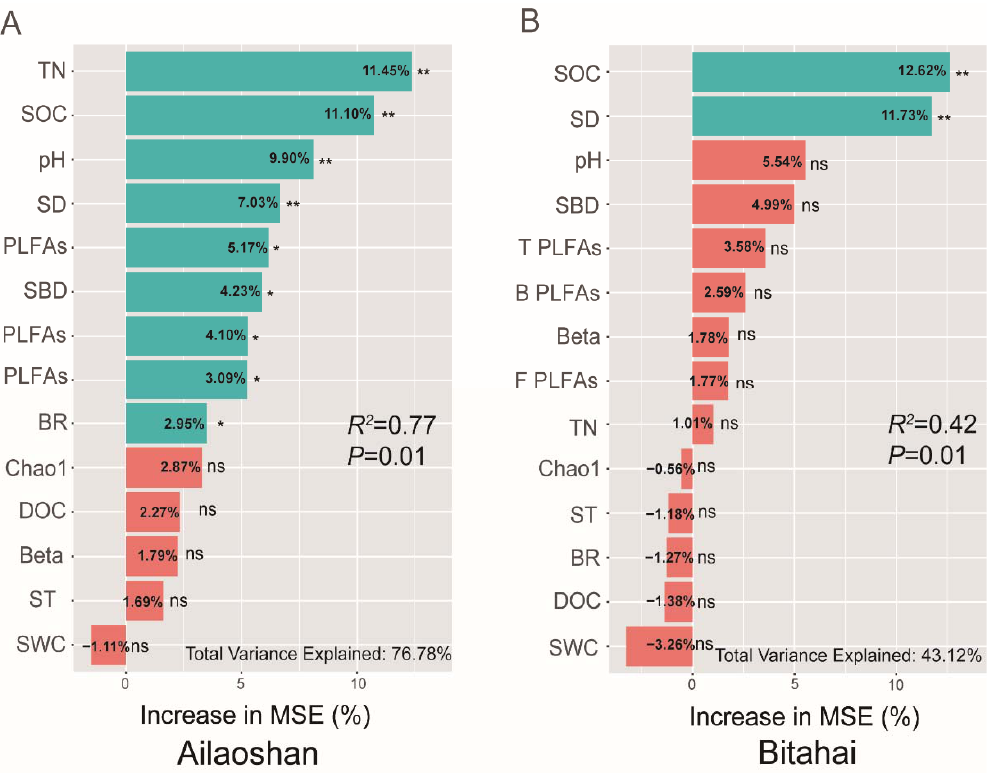
Figure 5. Effects of various factors on soil organic carbon stocks in Ailaoshan ( A ) and Bitahai ( B ) with random forest model. Factors in blue (*: P <0.05, **: P <0.01) represent sig ‐ nificant contribution to soil organic carbon stocks, while factors in red (ns) represent in ‐ significant contribution. BR: bryophyte removal, SOC: soil organic carbon, DOC: soil dis ‐ solved organic carbon, TN: soil total nitrogen, SWC: soil water content, SBD: soil bulk density, ST: surface temperature, SD: soil depth, T PLFAs: total microbial PLFAs, F PLFAs: fungal PLFAs, B PLFAs: bacterial PLFAs, Chao1: microbial Chao1 index, Beta: microbial beta diversity, Increase in MSE (%): percentage of increase of mean square error,